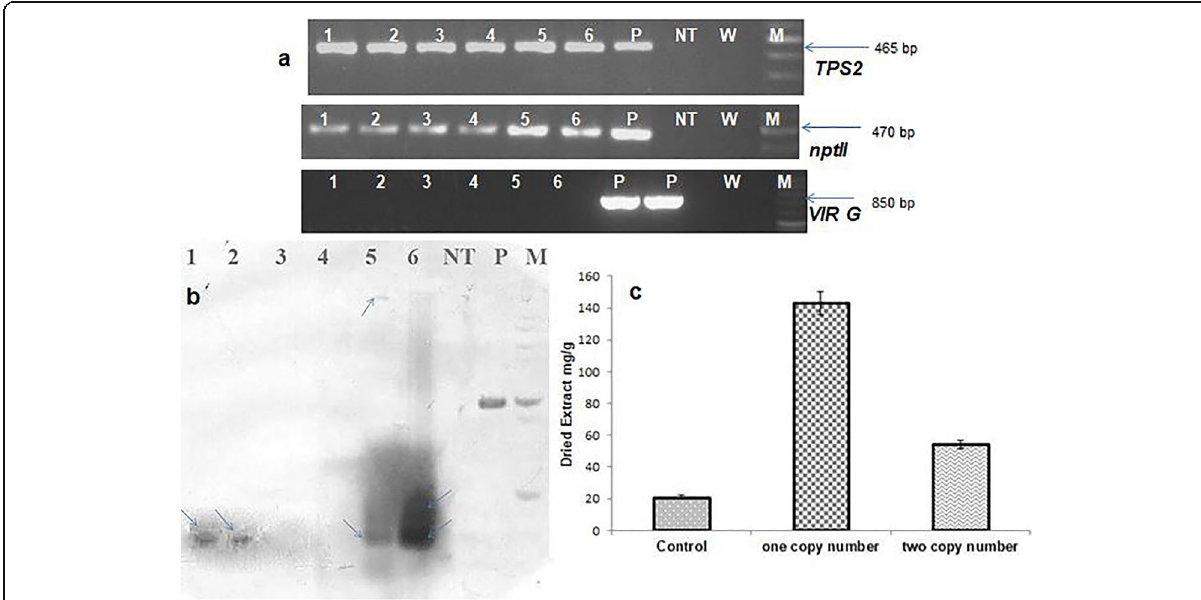
Fig. 4 a Detection of putative transgenic Trachyspermum ammi by PCR 1 – 3: putative transgenic plant using LBA4404, 4 – 6: putative transgenic plants using EHA101; NT: non-transgenic plant; P: positive control (plasmid) W: negative control (deionized water); M:100 bp DNA ladder. b DNA- blot analysis of transformed and non-transformed T. ammi . 1, 2, 5, and 6 transgenic plants; NT: non-transformed plant; P: positive control; M: